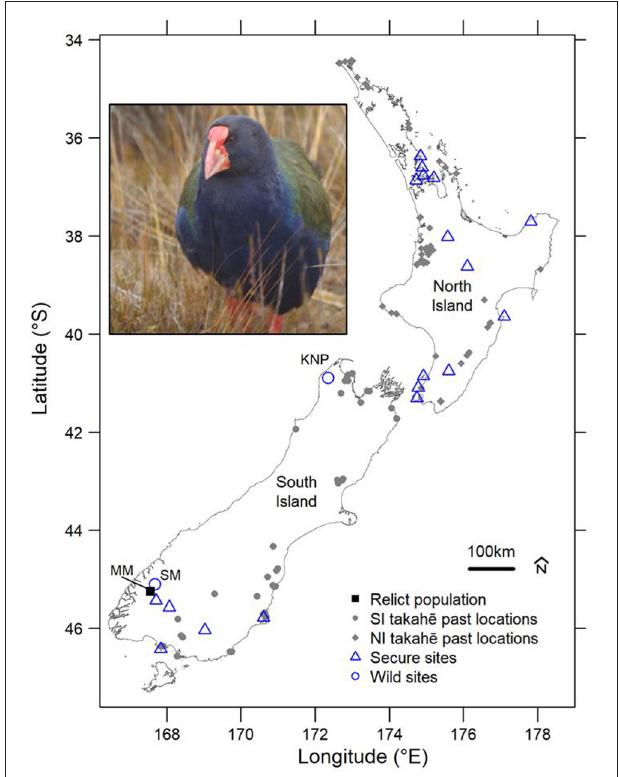
FIGURE 3 | Map: Takah ¯ e remnant and past locations as well as translocation release sites. Past locations (grey circles) from Holocene-aged fossil deposits (last 11,650 cal years BP, as determined by biochronological reasoning, namely the dominance of the moa Anomalopteryx didiformis; Worthy and Holdaway, 2002) are used to indicate of the pre/early human distribution of both North Island (NI) takah ¯ e ( Porphyrio mantelli ) and South Island (SI) takah ¯ e ( Porphyrio hochstetteri ). The relict population (Murchison Mountains, MM), wild sites (blue-outlined circles, SM, Stuart Mountains; KNP, Kahurangi National Park), and secure sites (blue-outlined triangles) are also shown. Inset: A South Island takah ¯ e following reintroduction to KNP; photo by